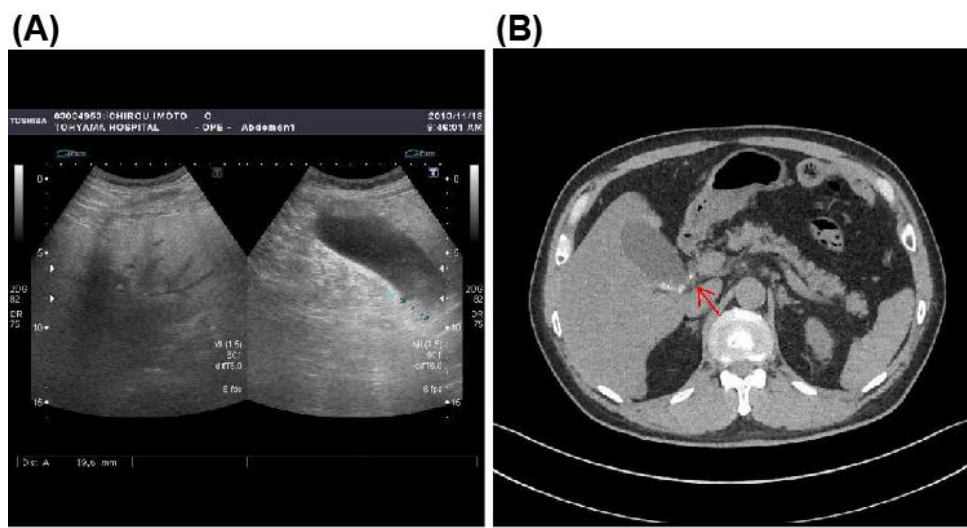
Figure 1. Abdominal ultrasonography and computed tomography findings. ( A ), Abdominal ultra- sonography revealed moderately fatty liver and numerous small stones and sludge in the gallbladder. ( B ), Abdominal CT revealed small stones in the enlarged gallbladder with suspicion of stone impaction (arrow) in the gallbladder neck.